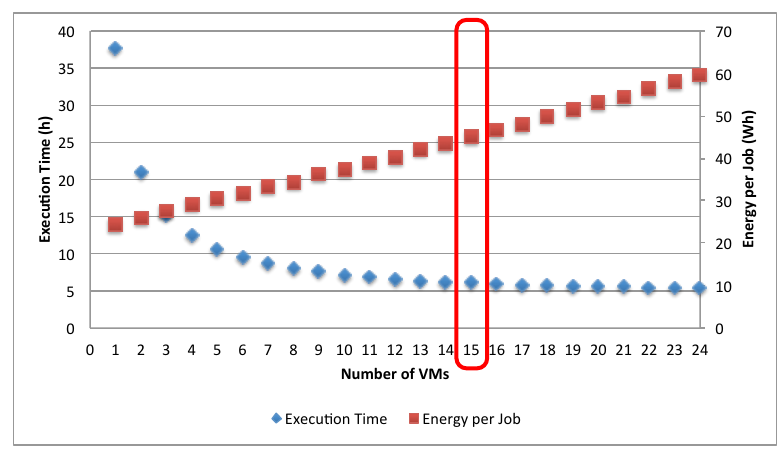
Figure 17. Execution time and energy per job with synchronous access.